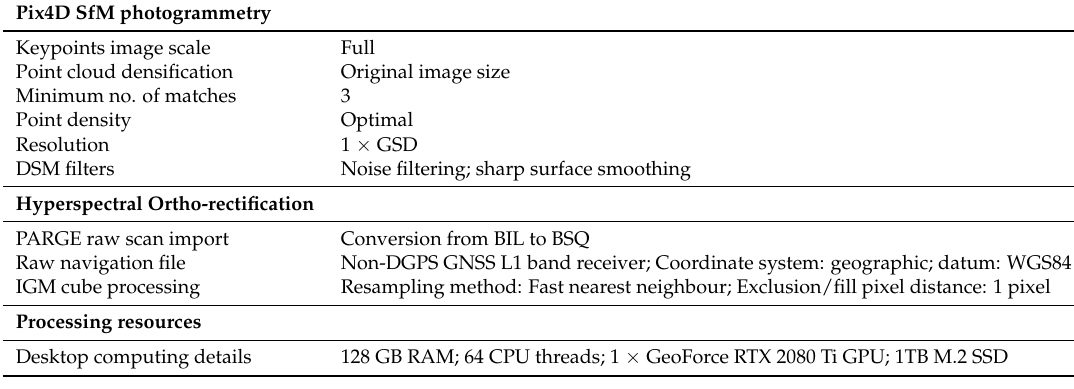
Table 3. Photogrammetry SfM & Hyperspectral imagery processing parameters.